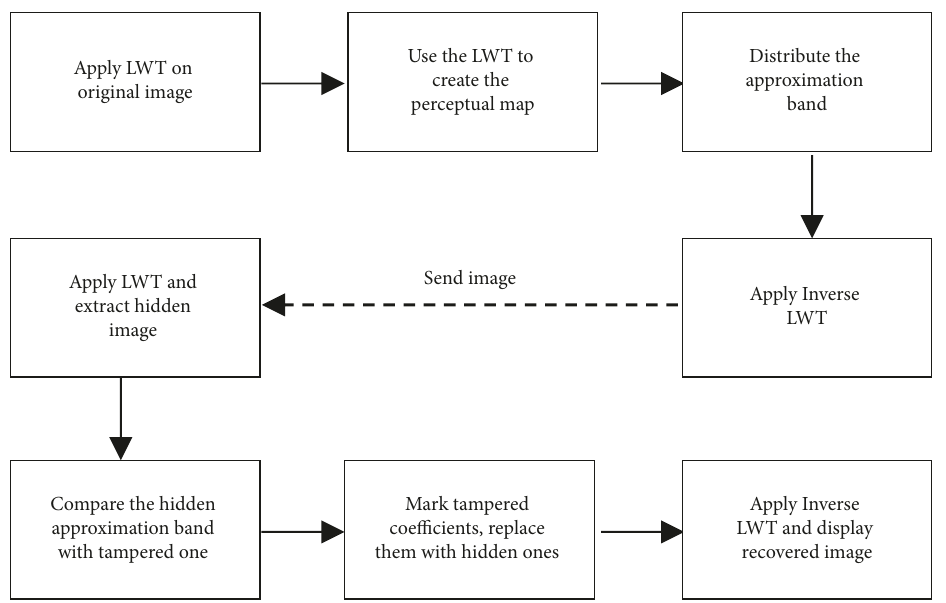
Figure 3: Phases of the proposed